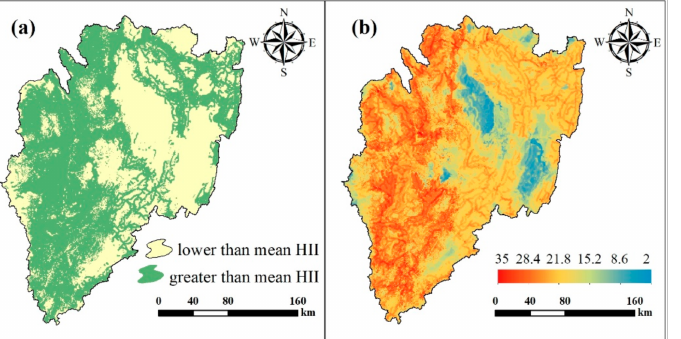
Figure 6. Human influence intensity (HII) map of the KB showing: ( a ) HII divided by its mean value; ( b ) the HII map of the KB.